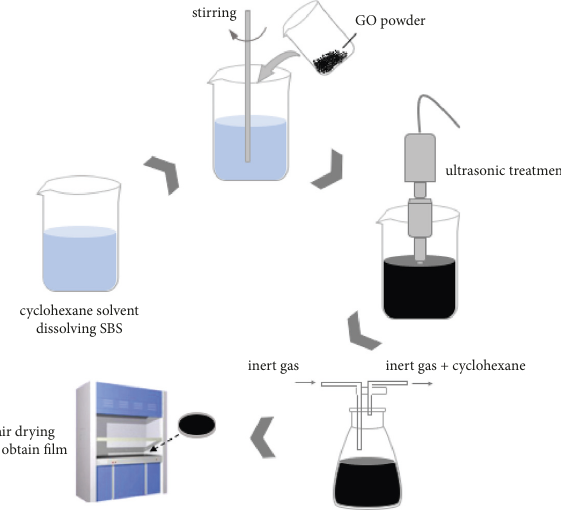
Figure 2: Preparation process of the GO/SBS